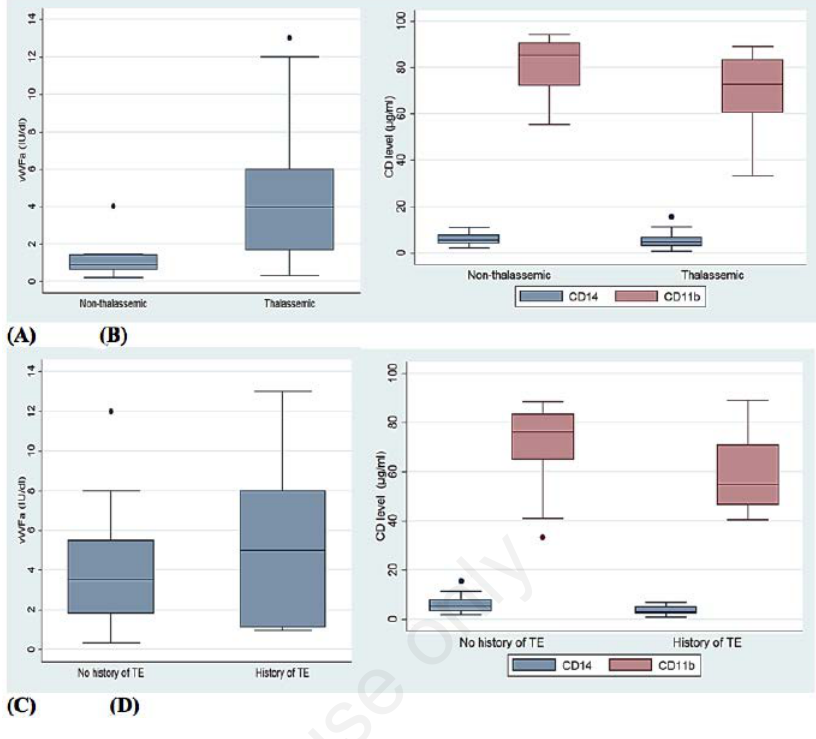
Figure 1. Box plot A showing the vWFa level in thalassemic patients and non-thalassemic controls, B showing the CD14 and CD11b level in thalassemic patients and non-tha- lassemic controls, C showing the vWFa level in thalassemic patients with or without his- tory of (TE), D showing the CD14 and CD11b level in thalassemic patients with or with- out history of